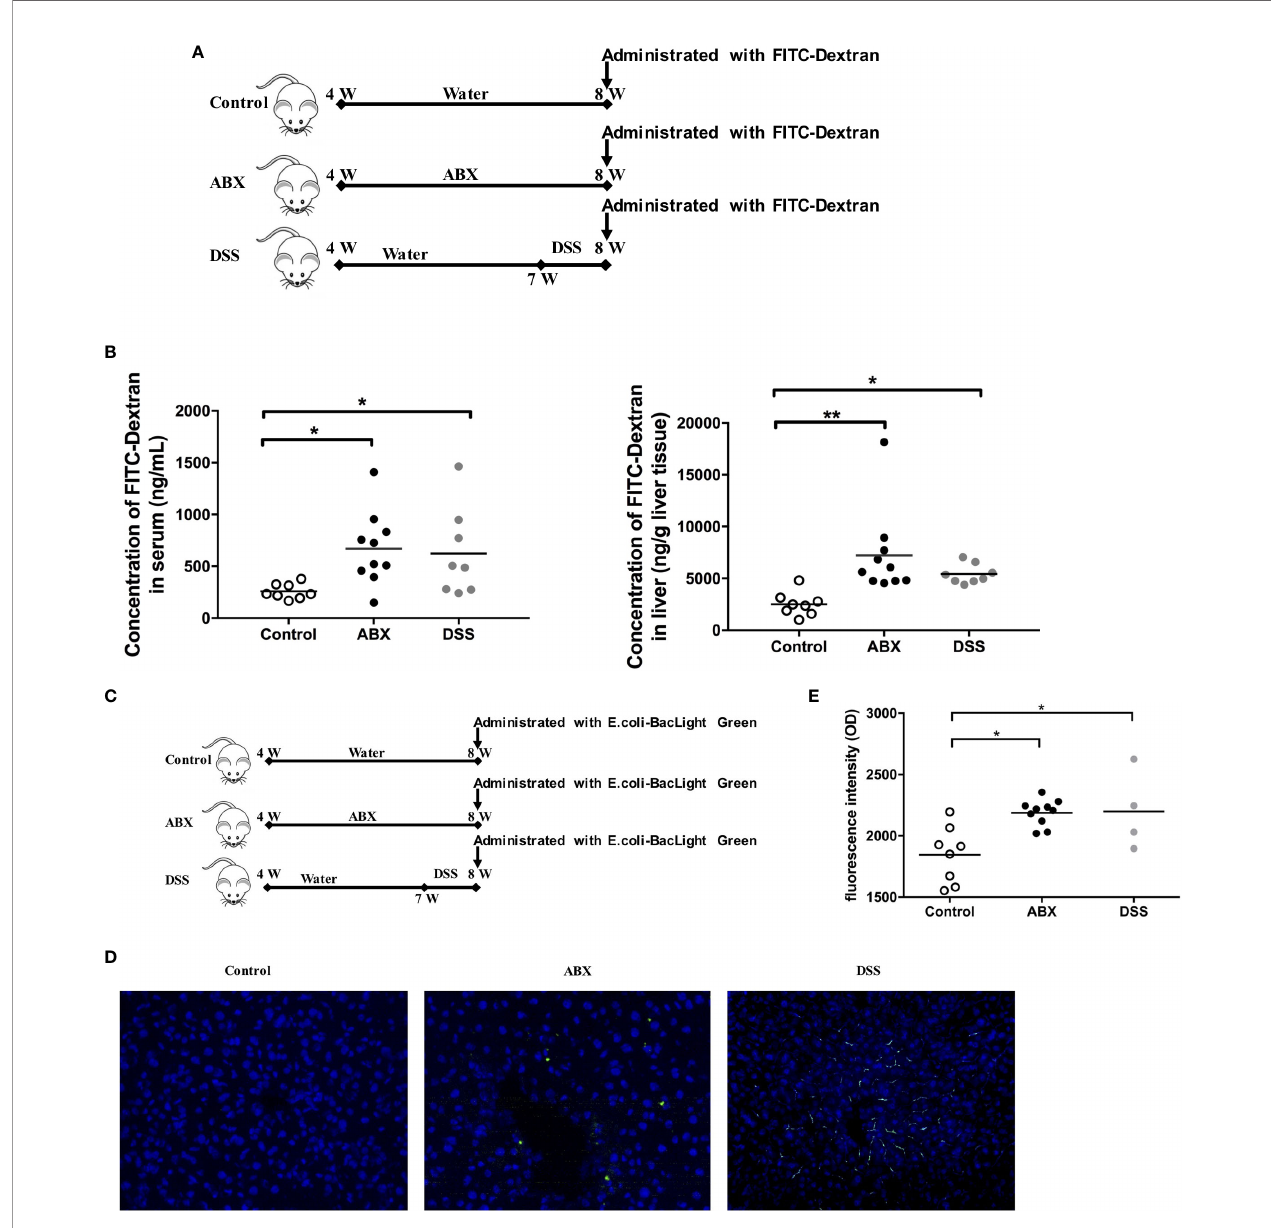
FIGURE 4 | Evaluation of gut permeability and tracing of live bacterial translocation in vivo . (A) Schedule of the therapy. Mice were fed water or ABX from week 4 to week 8. For the positive control, mice were fed with water from week 4 to week 7, then switched to DSS till week 8. After termination of the therapy for 24 hours, mice were administered FITC-Dextran using oral gavage. (B) The concentrations of FITC-dextran in sera and liver homogenates 2 h after administration. (C) Schedule of the therapy. After termination of the therapy for 24 hours, mice were administrated with live BacLight Green-labeled E . coli using oral gavage. (D) The live E . coli -BacLight Green in liver tissue sections (400×) and (E) the fl uorescence intensity in sera 4 h after administration. n=10/group, *P < 0.05, **P <